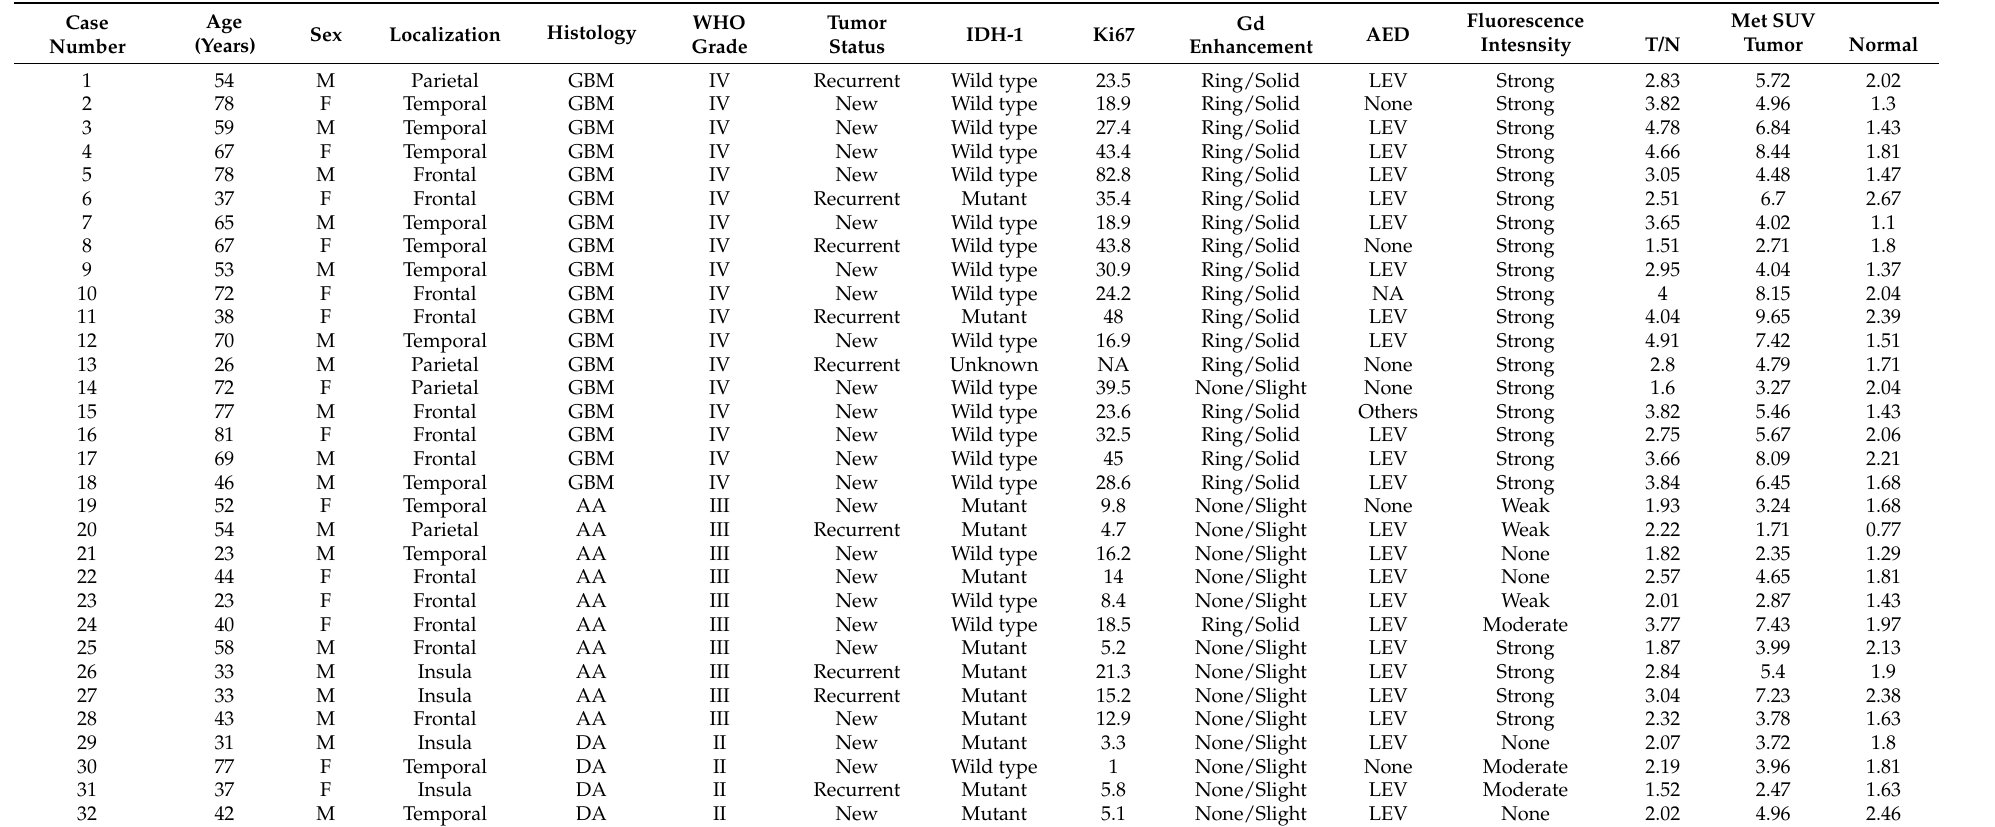
Table 1. Patient